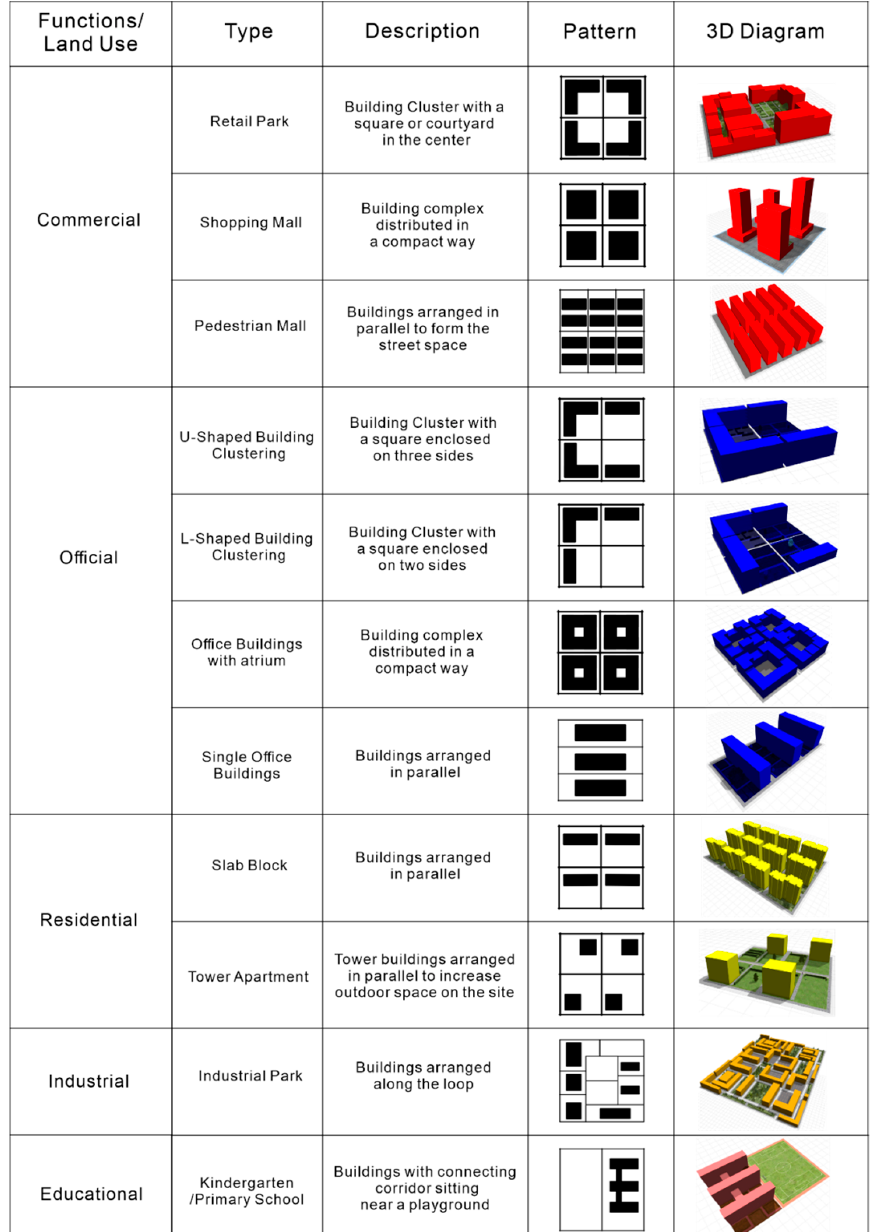
Figure 5. Various urban forms of different urban functional zone generated by land-use-based combination of building types and layout.